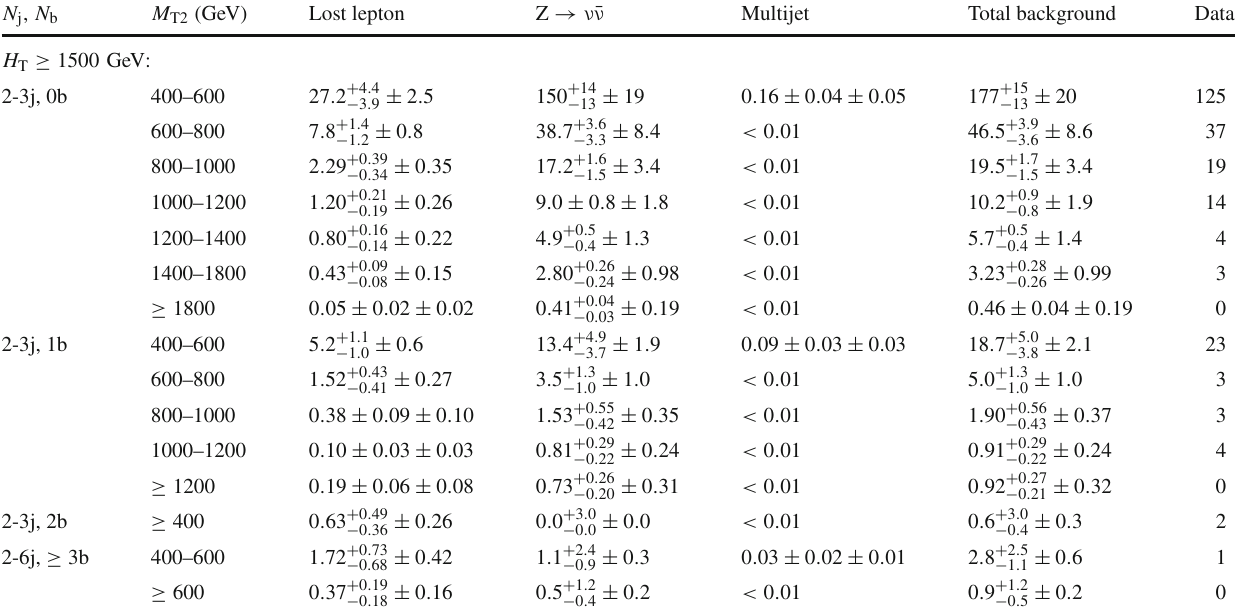
Table 22 Predictions and observations for the 30 search regions with H T ≥ 1500 GeV, and 2 ≤ N j ≤ 3, 2 ≤ N j ≤ 6 and N b ≥ 3, or 4 ≤ N j ≤ 6. For each of the background predictions, the first uncer-